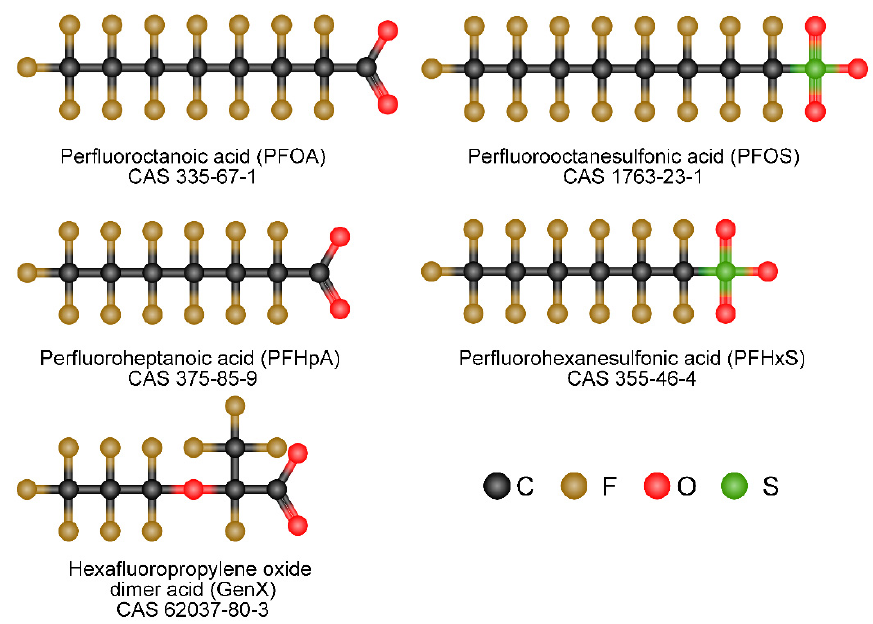
Figure 1. Chemical structures of Poly ‐ and perfluoroalkylated substances. Structures are based on 2D structures from PubChem accessed 5 June 2022 and assembled in Chem ‐ space.com accessed 5 June 2022.